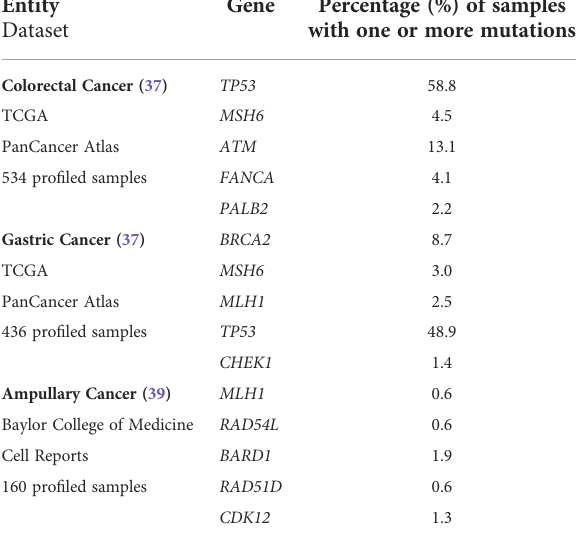
TABLE 5 Frequency of mutations in DNA repair-related genes in different digestive system cancers according to large publicly available